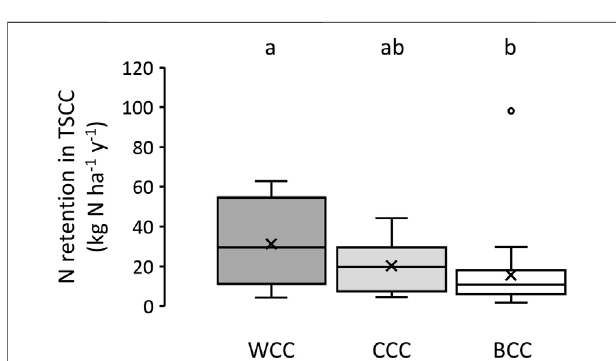
FIGURE 9 | Box and whiskers plot of potassium retention in TSCC for each of the cover crop layouts. Horizontal black line, x-shaped cross, box borders and whiskers stand for the median, the mean, quartiles and outliers. Different letters over the box-plot indicate signi fi cant differences ( p < 0.05).WCC,CCCandBCCstandforolivesgroveswhereTSCCoccupiedthe wholearea,wasabsentundertreecanopyoronlyoccupiedastripoftheinter- row area,